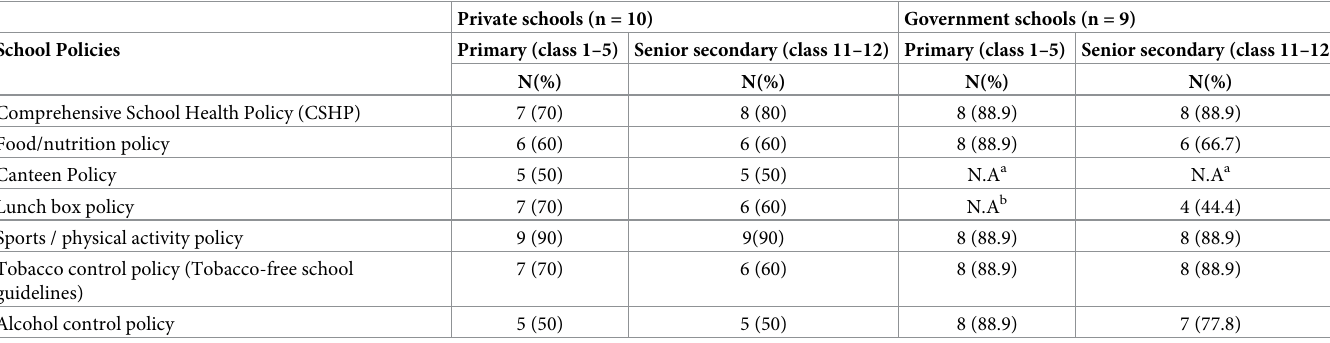
Table 1. School health policies by class and type of school reported by